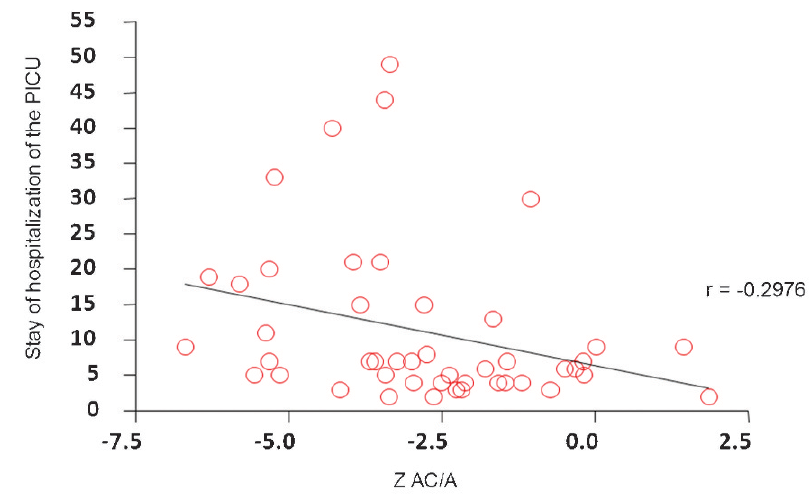
Figure 1 - Correlation between stay of hospitalization in PICU and Z-score AC/A of children after liver transplantation.